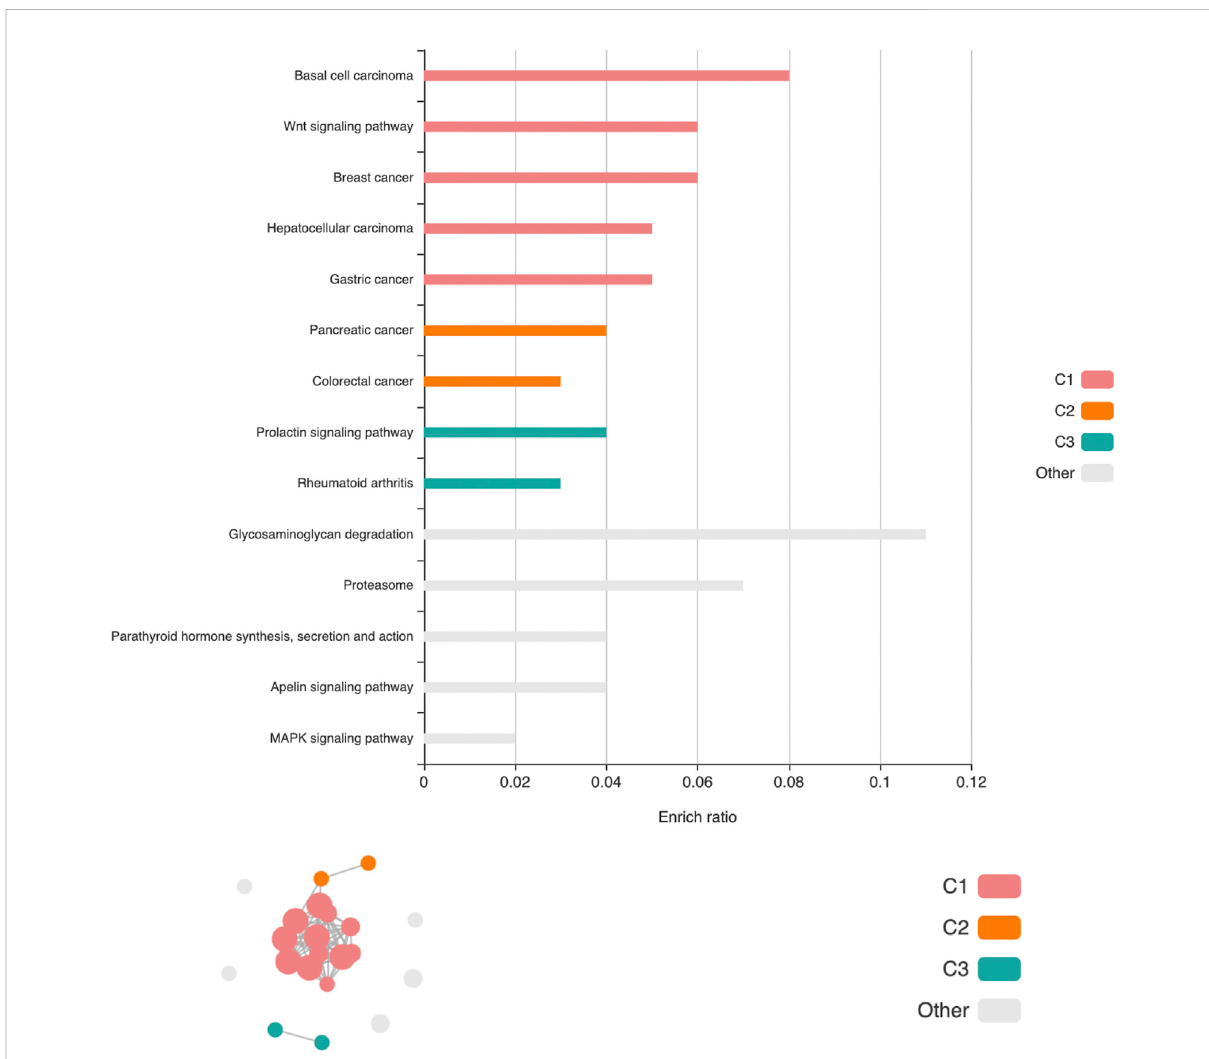
FIGURE 5 ThecirFunMapplotofthepathwaynetworkisbasedon173top-hitgenesfromBMD-relatedstudies.Above:Thebarplotoftheenrichmentratio is de fi ned as thenumber of top-hit genes in the pathway over the number of total genes in thepathway. Below: The circular network plot. The node color represents different clusters. The node size represents the levels of p -value: from small to large: (0.01,0.05), [0.001,0.01), (0.0001,0.001), and (1e-10,0.0001). The edge represents correlations larger than a default threshold of